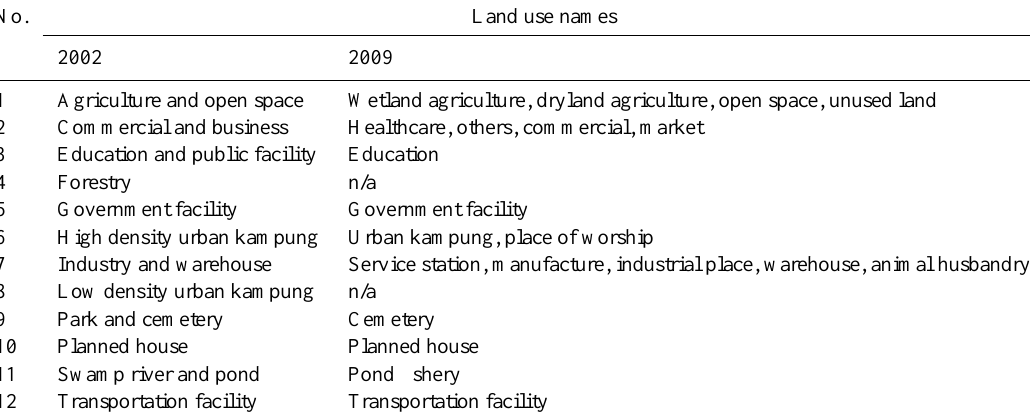
Table 1. Reclassification of 21 land use classes from the land use map 2009 to the 12 land use classes of the land use map 2002. No.